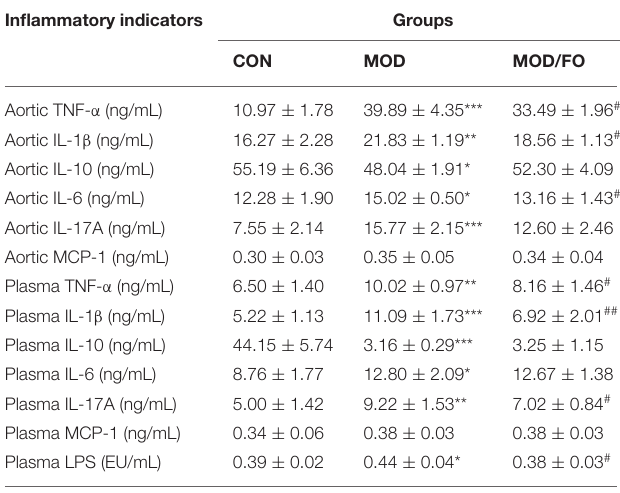
TABLE 1 | Determination of plasma and aortic inflammatory cytokine levels and plasma lipopolysaccharide (LPS) in diverse groups. Inflammatory indicators